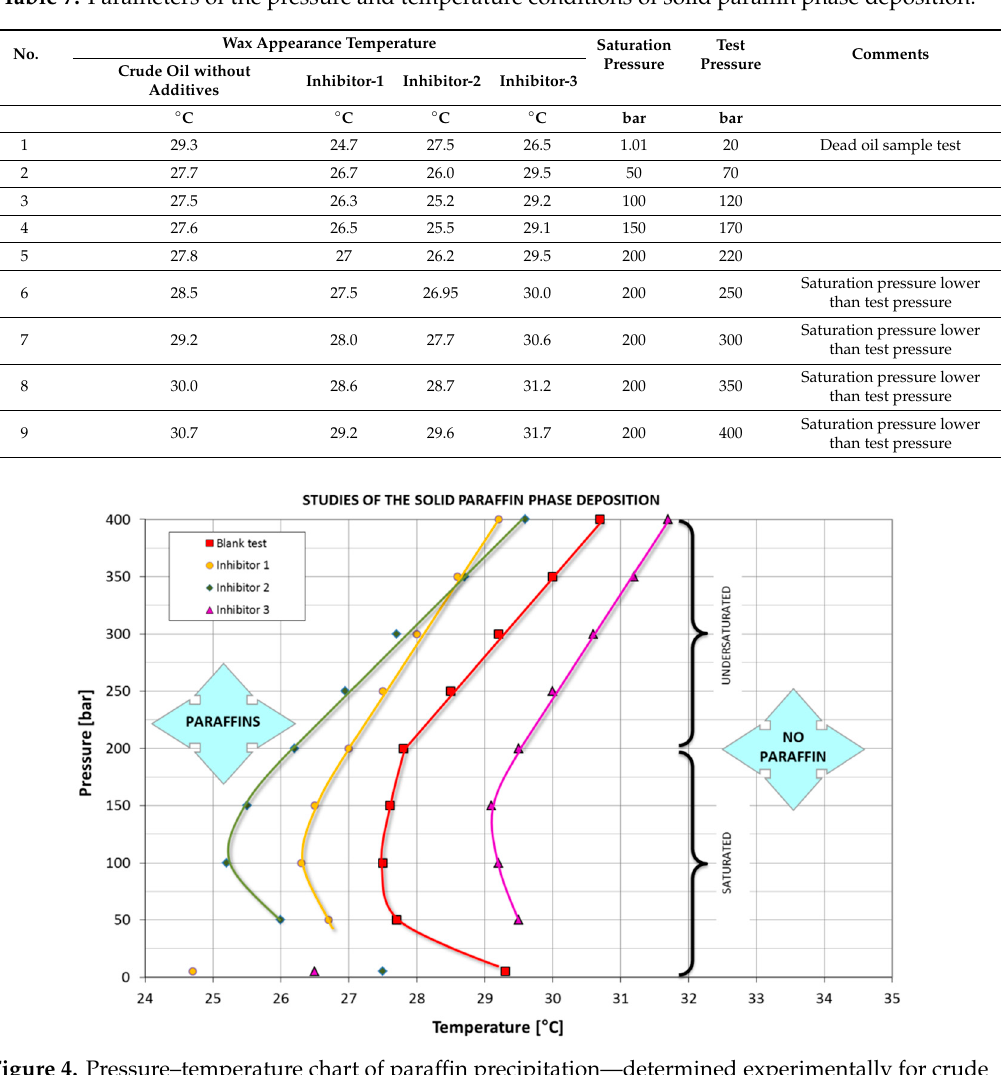
Table 7. Parameters of the pressure and temperature conditions of solid paraffin phase deposition